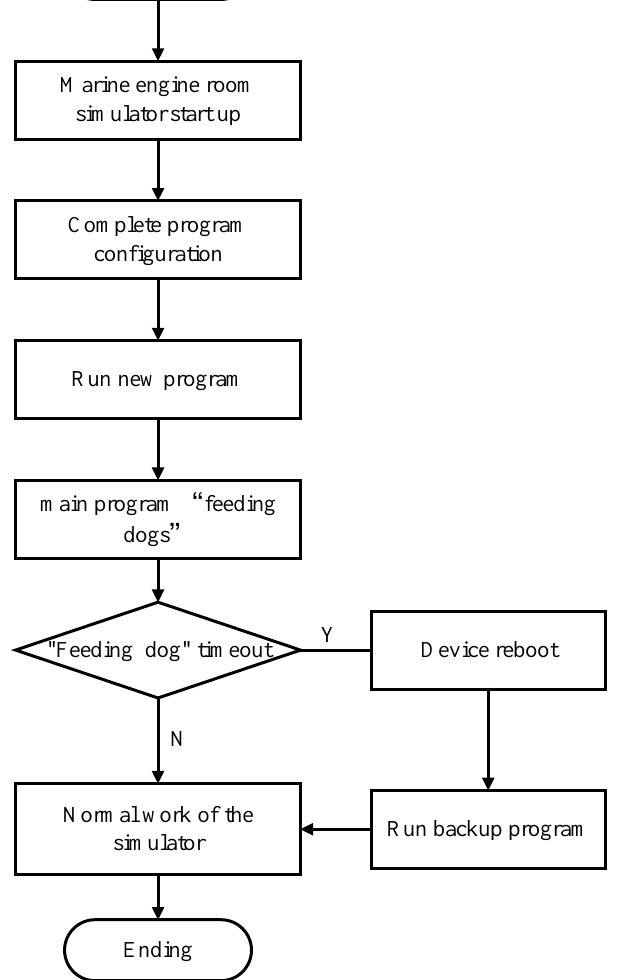
Figure 7. Flow chart of backup